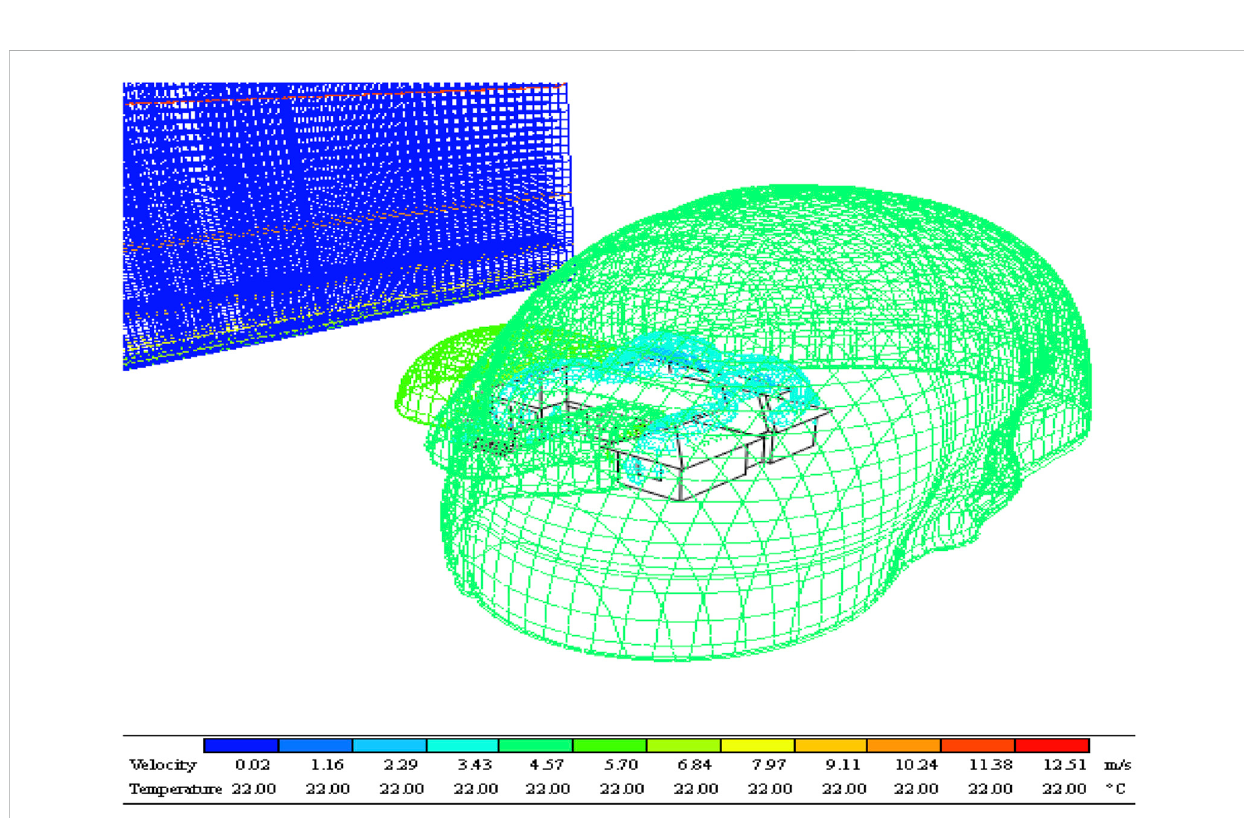
FIGURE 9 Best-case situation.